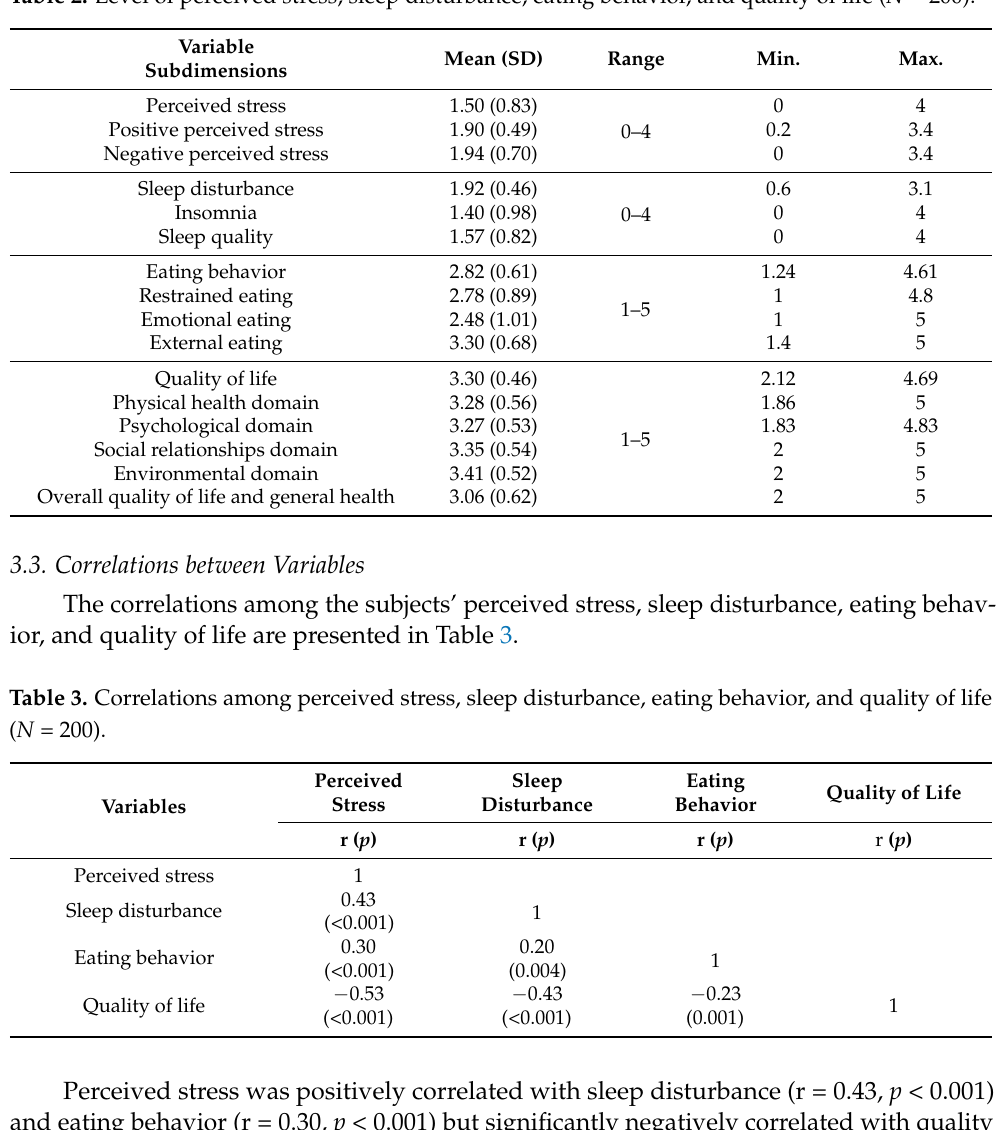
Table 2. Level of perceived stress, sleep disturbance, eating behavior, and quality of life ( N = 200).